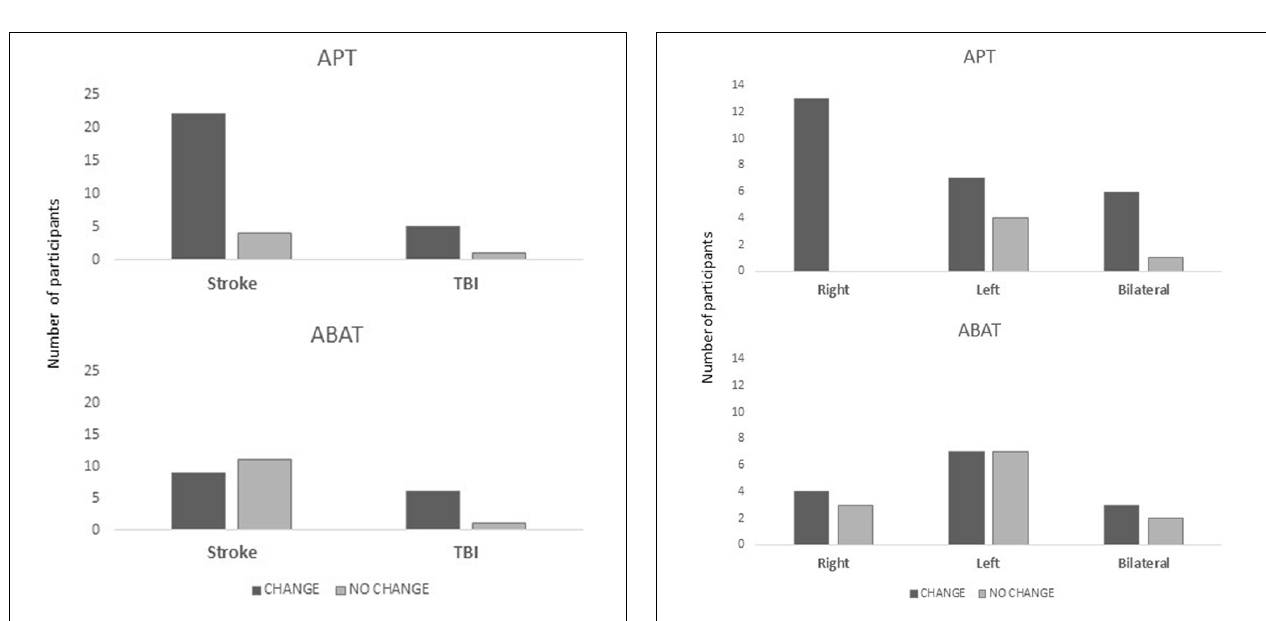
FIGURE 2 | Distribution of patients in the CHANGE vs. NO CHANGE groups split for diagnosis (stroke, TBI) and treatment (APT, Attention Process Training; ABAT, Activity-Based Attention Training), where the y-axis indicates the number of patients in each subgroup.